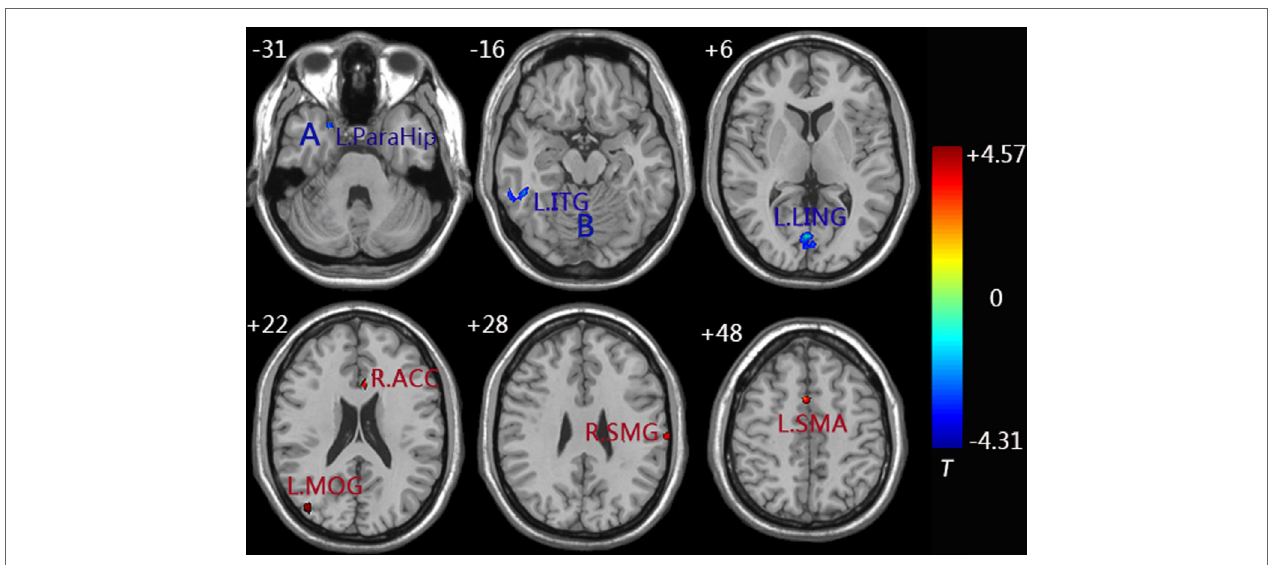
ITG, inferior temporal gyrus; ParaHip, parahippocampus; SMG, supramarginal gyrus; SMA, supplementary motor area; L, left; R, right; Letter A represents the left ParaHip and letter B represents the left ITG.